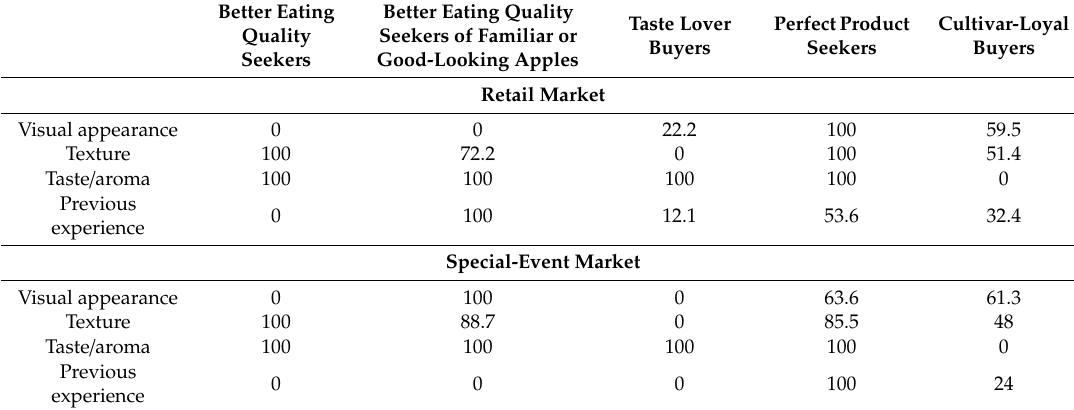
Table 3. Frequencies of selection of the top four reasons for the purchase of apples by five di ff erent classes of customers at the retail and special-event markets.